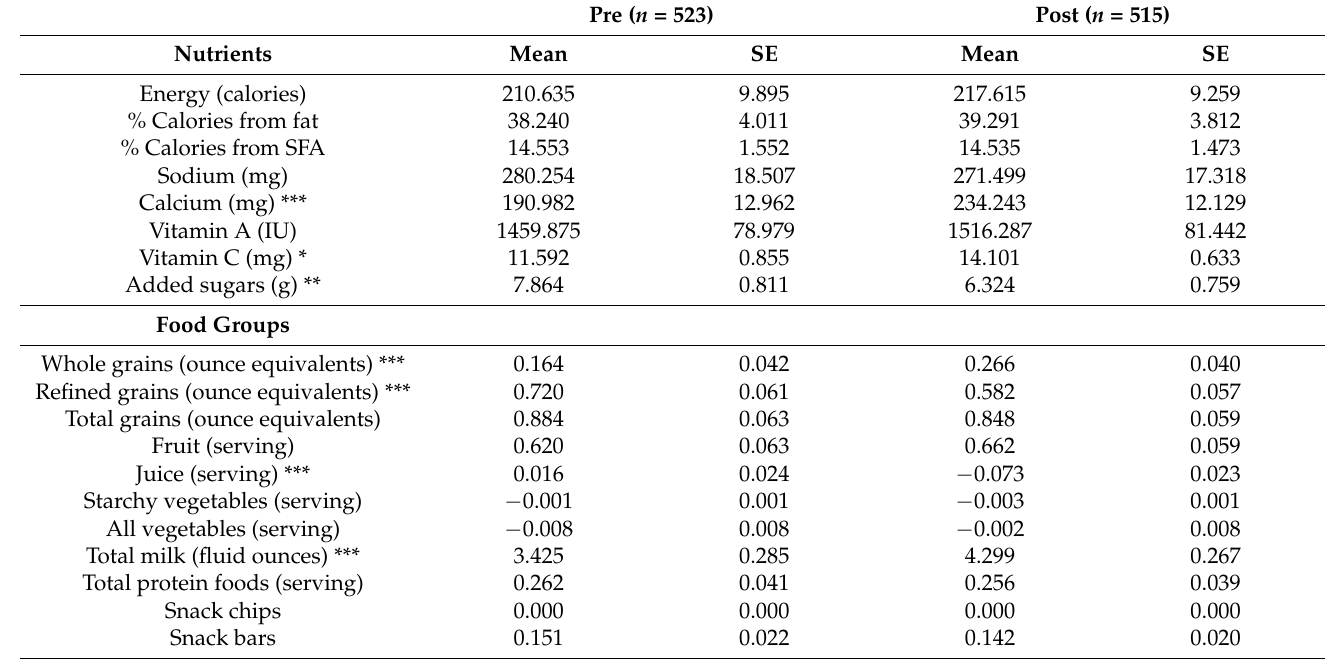
Table 2. Adjusted means of nutrients and food groups consumption at breakfast.